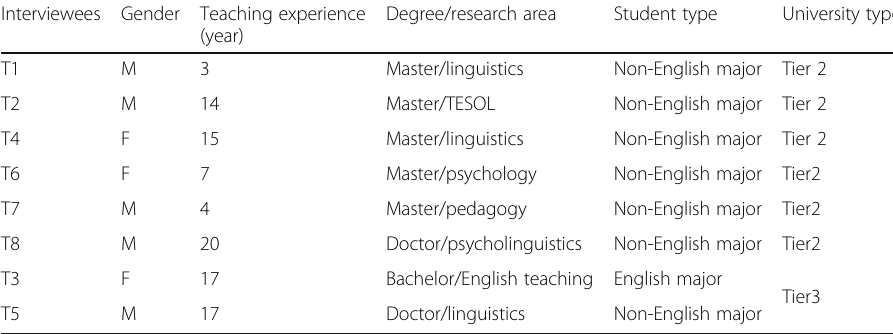
Table 1 Basic information for interview participants Interviewees Gender Teaching experience